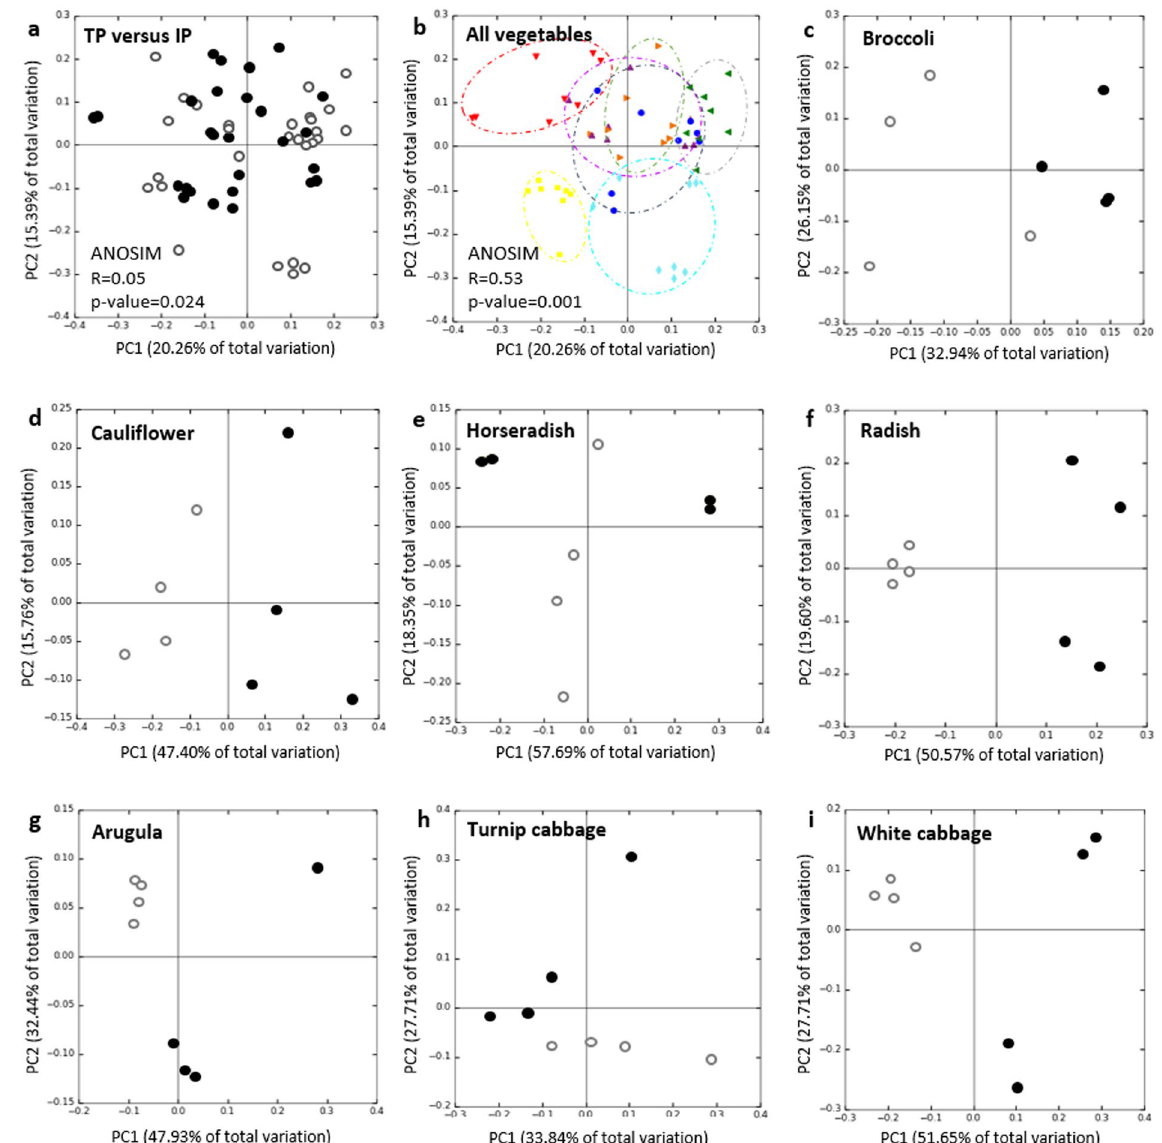
Figure 1. Beta-diversity metrics of bacterial 16S rRNA gene of the vegetable samples visualized by PCoA plots. Community clustering is based on Bray-Curtis dissimilarities (weighted UniFrac) in the relative abundance of OTUs. ( a ) Bacterial community composition of the pooled traditionally processed samples (TP; filled circles) and the pooled industrially processed samples (IP; open circles). ( b ) Microbiome variations derived from the vegetable genotype. The colors of the symbols denote for the different vegetables: horseradish (red), arugula (yellow), radish (turquoise), white cabbage (blue), turnip cabbage (green), cauliflower (orange) and broccoli (purple). Circles were drawn for a better visualization of the clusters. ANOSIM describes impact and significance of processing pathway (R = 0.05; p-value = 0.024) and plant genotype (R = 0.53; p-value = 0.001) on the microbiome structure. ( c – i ) Partitioning of bacterial communities associated with the processing equivalents of each vegetable type. Filled circles denote for traditionally processed samples, open circles show industrially processed